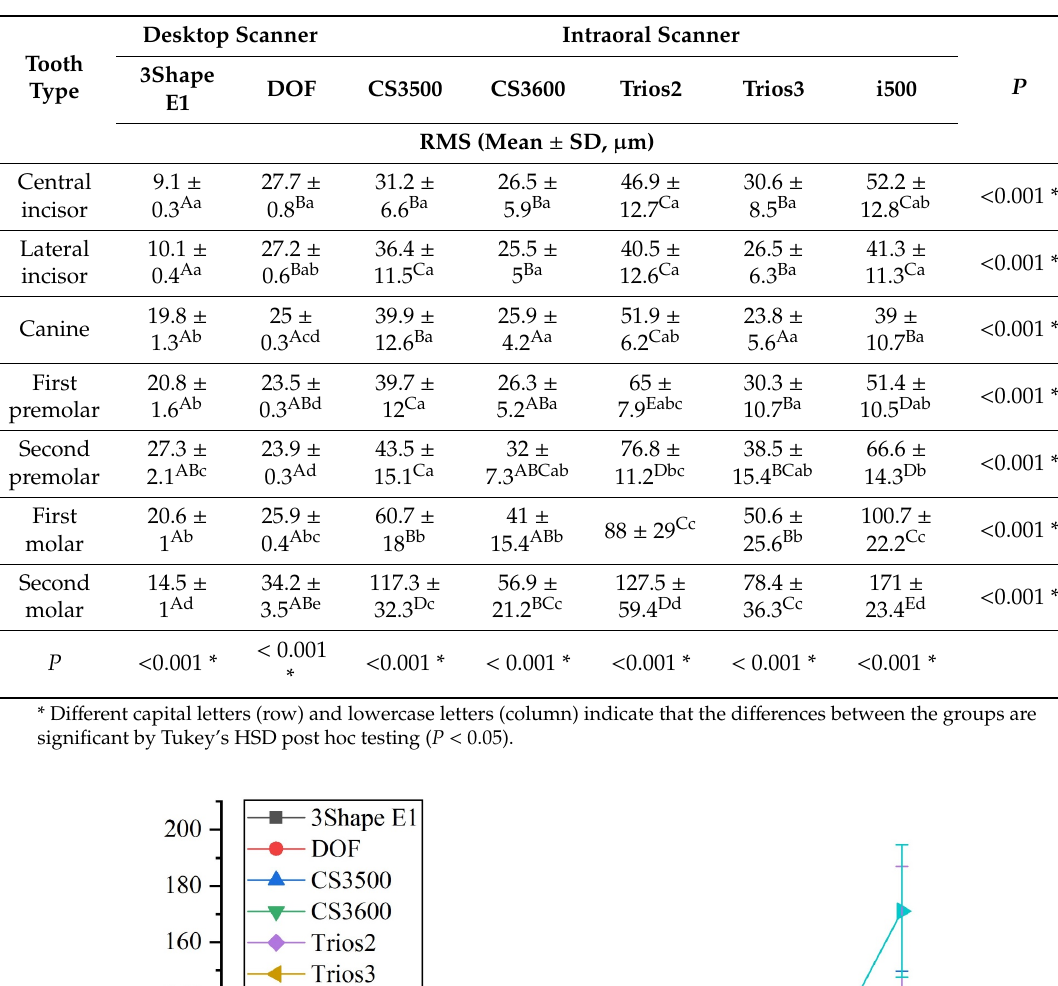
Table 2. Comparison of the accuracy of 3D scanners according to the tooth type.